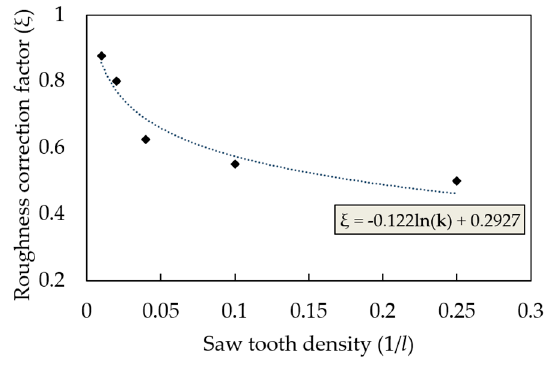
Figure 24. Roughness correction factors of different conditions.